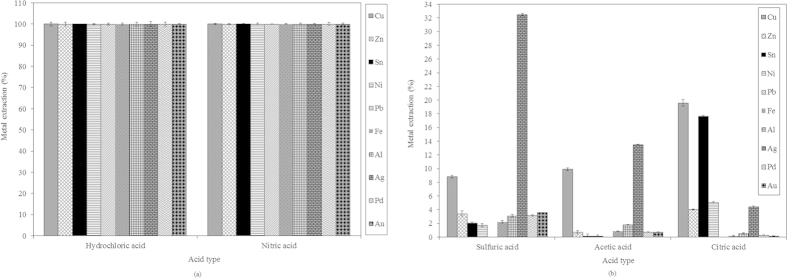
Amounts of metals recovered from a 4 cm × 4 cm PCB piece (a) by HCl and HNO3 and (b) by H2SO4, C2H4O2 and C6H8O7, at 150 rpm and room temperature.